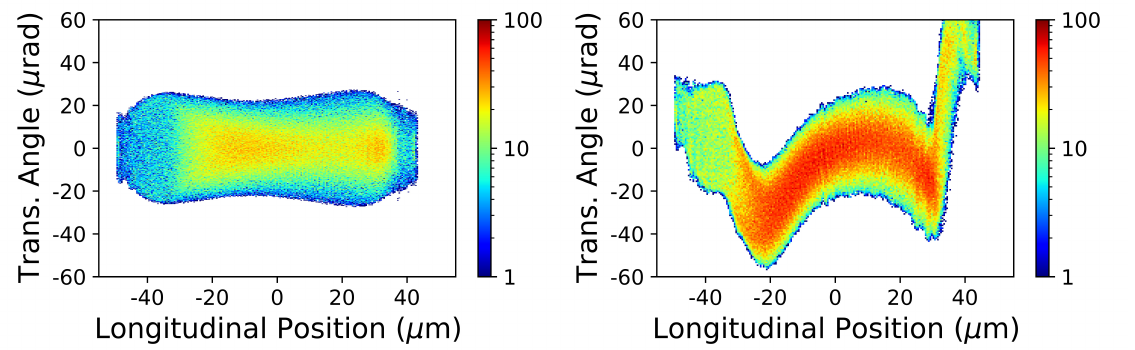
Figure 5. Dependence of the transverse angle on the longitudinal coordinate are shown, on the left without coherent synchrotron radiatio (CSR) effects and with CSR effects on the right. In both plots, the beam head is to the